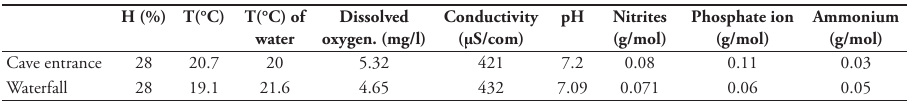
table 1. Measurements of physical and chemical parameters at two localities in the cave system (see Fig. 2, May